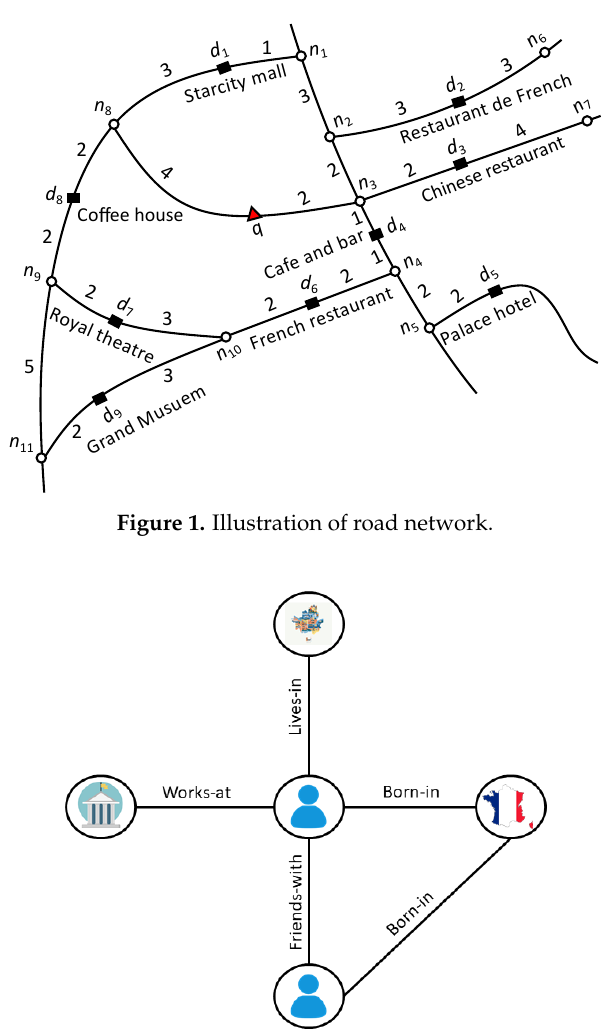
Figure 2. Illustration of geo-social network.